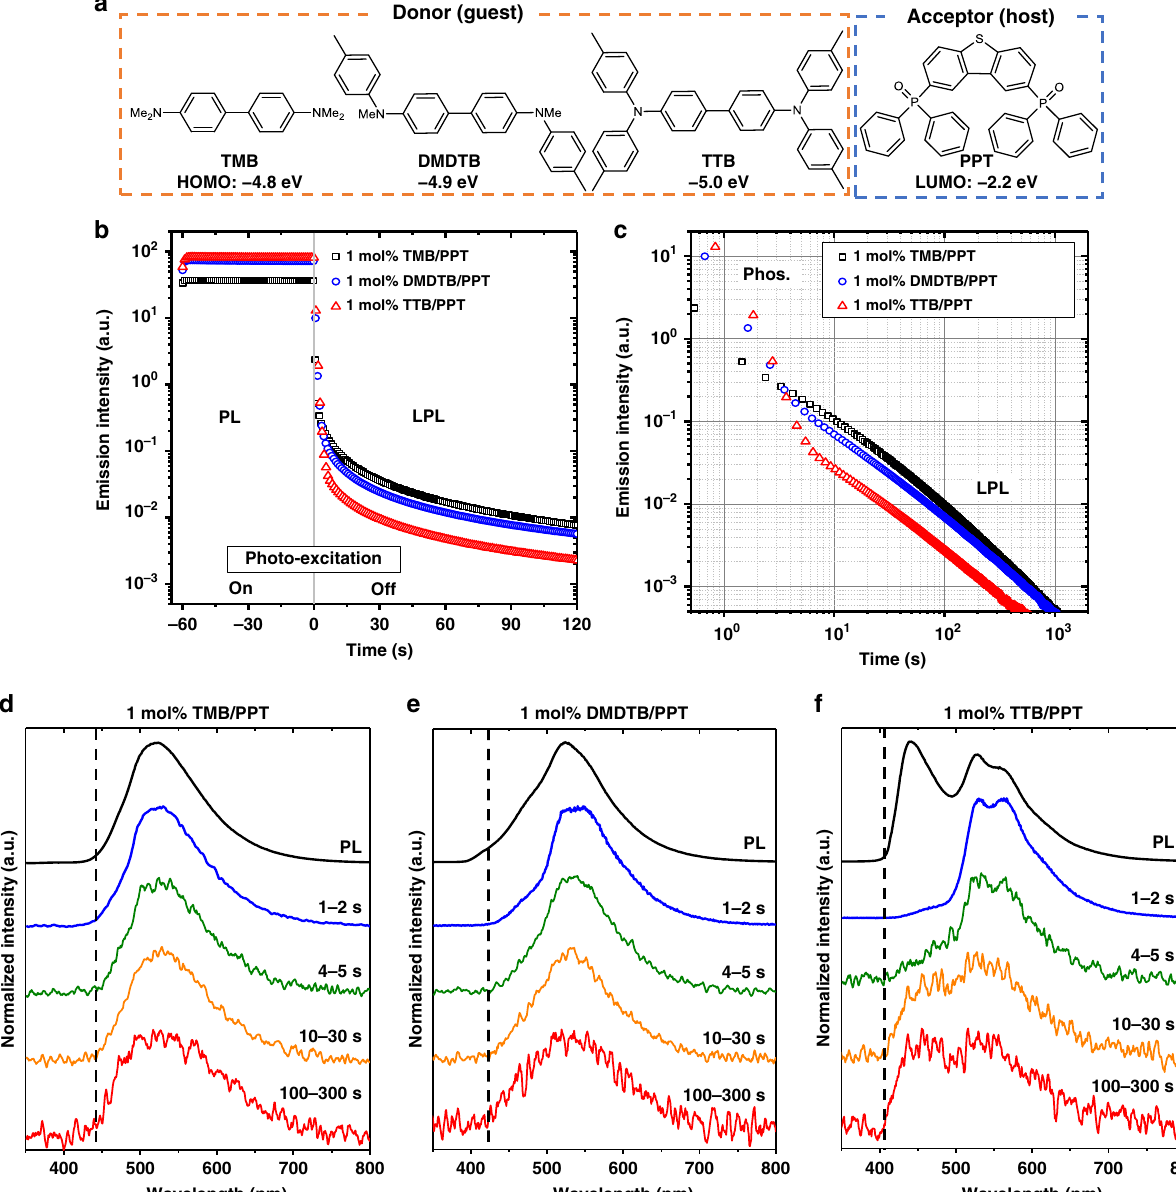
Fig. 2 Photoluminescence and LPL characteristics of the OLPL systems. a Chemical structures and HOMO or LUMO energy levels of the three electron donors (TMB, DMDTB, and TTB) and the electron acceptor (PPT). b , c Semi-logarithmic plots ( b ) and logarithmic plots ( c ) of the emission decay pro fi les of TMB/PPT, DMTDB/PPT, and TTB/PPT at 300 K. Emission decay pro fi les contain all of the emission over wavelengths from 400 to 900 nm. Samples were excited for 60 s (from − 60 to 0 s) by a 340 nm LED source. PL means the steady-state photoluminescence, LPL means the long-persistent luminescence, and Phos. means the phosphorescence. d – f The steady-state photoluminescence and time-resolved photoluminescence spectra of 1 mol% TMB/PPT ( d ), DMDTB/PPT ( e ), and TTB/PPT ( f ) fi lms at 300 K. The time-resolved spectra were integrated over periods of 1 – 2, 4 – 5, 10 – 30, and 100 – 300 s after stopping excitation. The dashed lines indicate the onset of the LPL